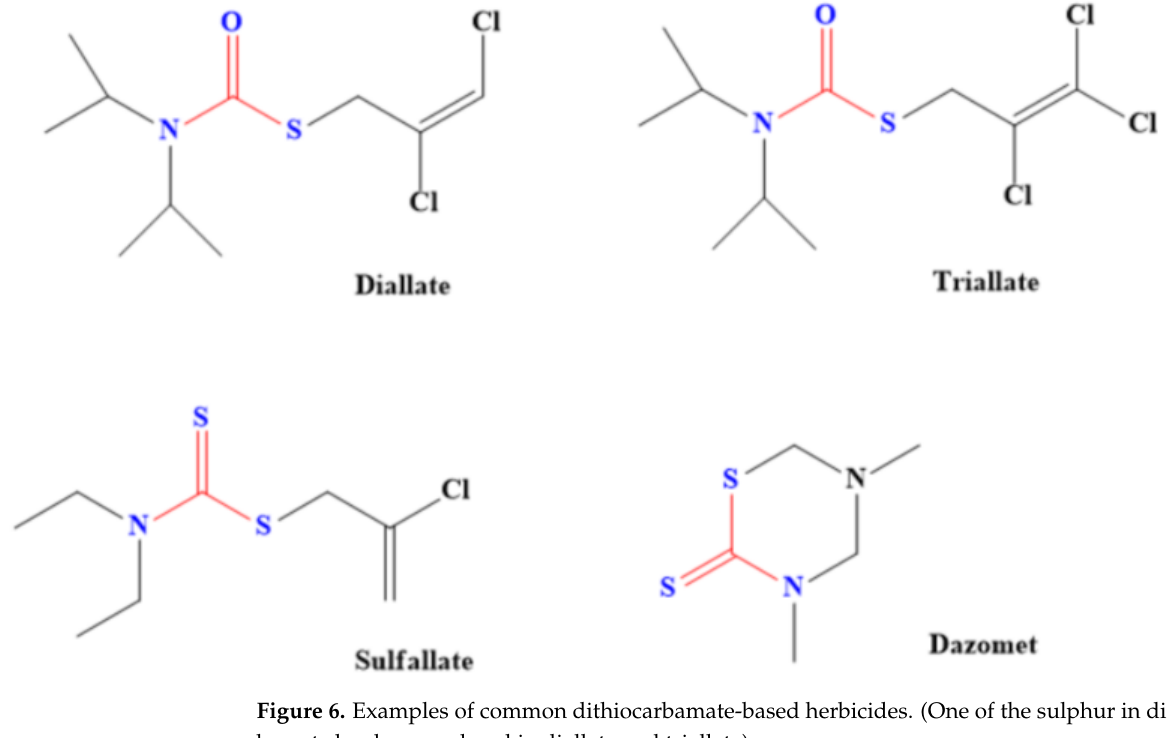
Figure 6. Examples of common dithiocarbamate-based herbicides. (One of the sulphur in dithiocar- bamate has been replaced in diallate and